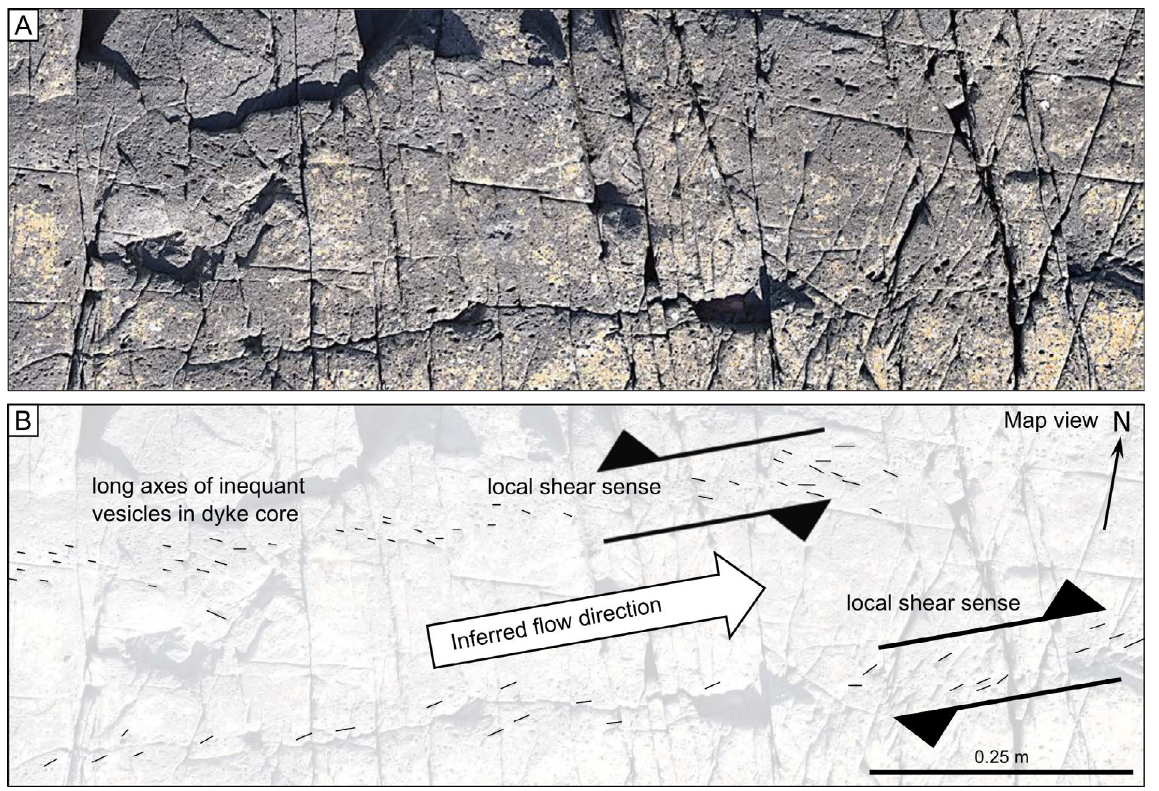
Figure 12: Preferred orientations of shaped vesicles in Dyke 0 East. [A]–[B] Photograph and interpretation of patterns of vesicles observed in the core of one segment of Dyke 0 East (see Figure 3 for location). Only about 1 metre of the dyke is shown, but this pattern extends for at least 10 metres on the ground. Two sub-parallel trains of vesicles can be found each about 20 cm in from the dyke margin. Many vesicles are elliptical in this horizontal (map view) cross-section, with their long axes oriented in opposite trends on either side of the dyke centre line. The northernmost vesicle train has long axes oriented approximately WNW/ESE whereas the southernmost train has long axes oriented approximately ENE/WSW. Assuming the vesicles were originally spherical with circular cross-sections in 2D, this pattern is consistent with a shear deformation due to eastward flow of the dyke